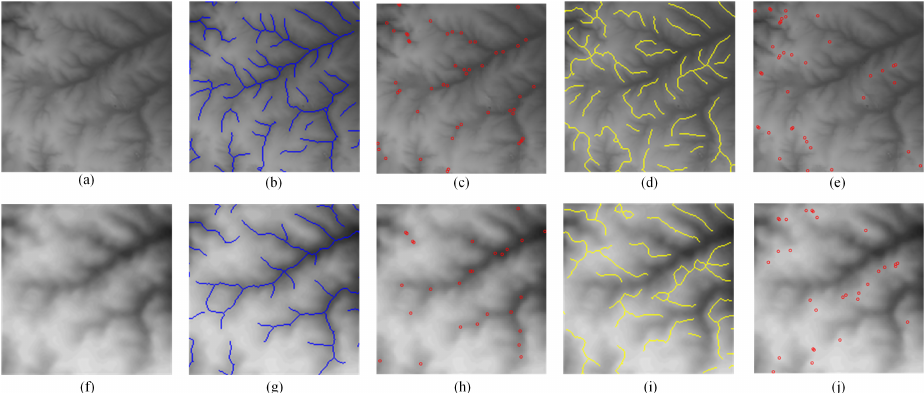
Figure 8. Branch point extraction results. ( a – e ) Real interference fringe. ( f – j ) Reference interference fringe. ( b , g ) Valley line extraction results. ( c , h ) Valley branch point extraction results. ( d , i ) Ridge line extraction results. ( e , j ) Ridge branch point extraction